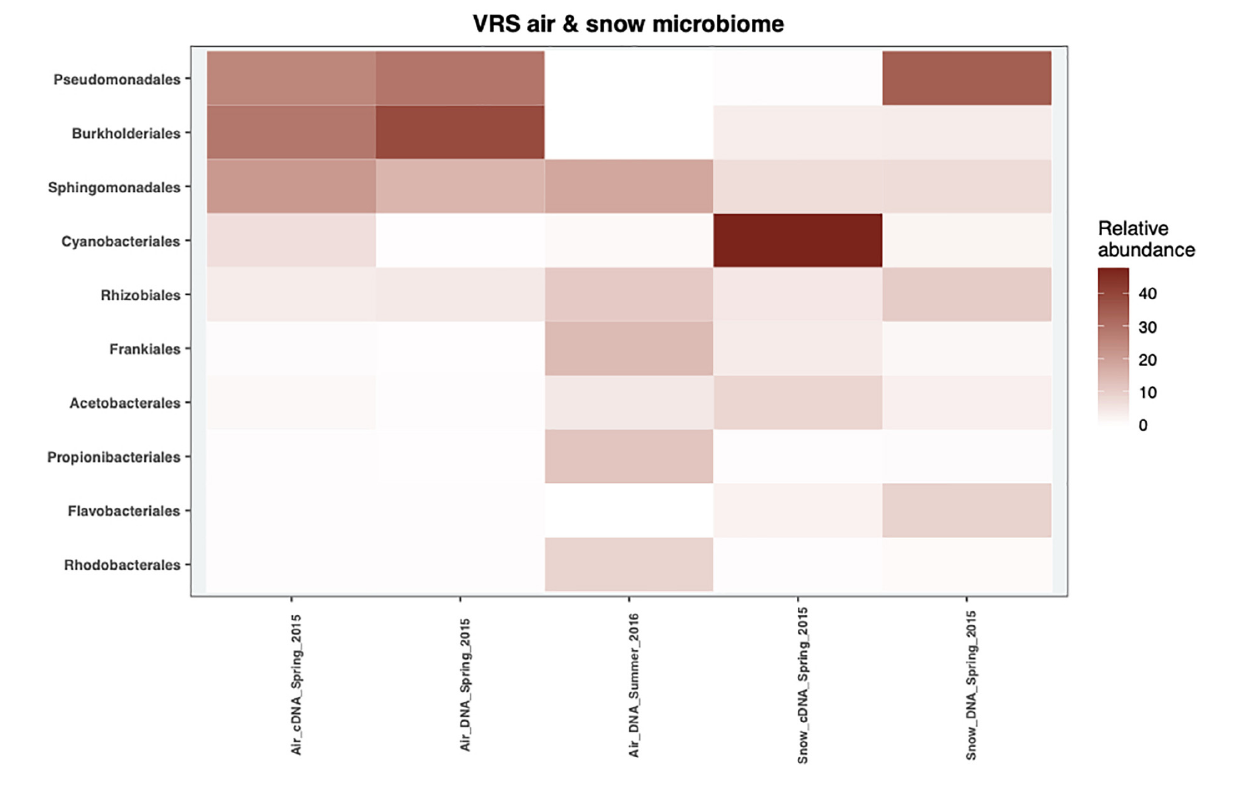
FIGURE 3 | The mean relative abundance of the top 10 most abundant orders in 2015 and 2016 of the cDNA-level and DNA-level bacterial communities from snow and